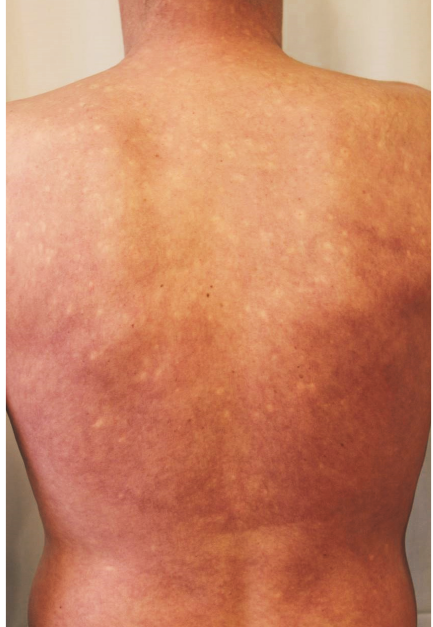
Figure 3: Findings on discharge. Complete healing under postin- flammatory